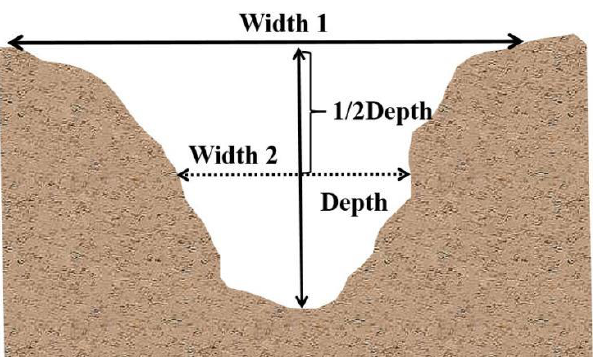
Figure 3. Schematic diagram of rill morphological parameters.